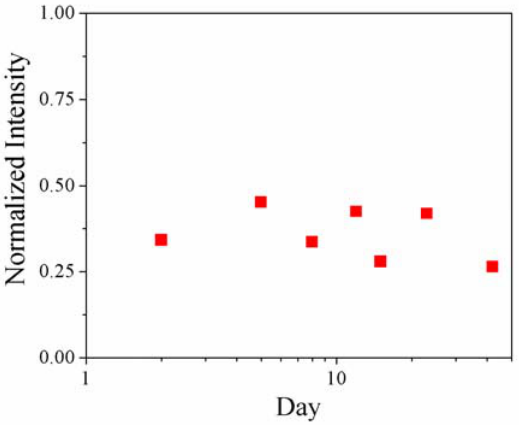
Figure 8. Fluorescent labeling intensities of biotinylated devices for given storage times, normalized according to device surface area. Note that the x-axis is plotted on a